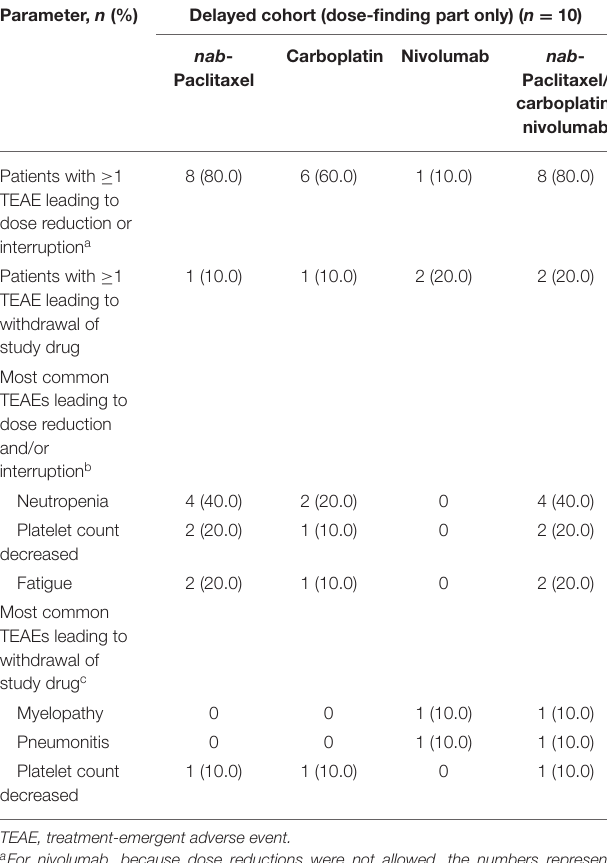
Table 3a | TEAEs leading to dose reduction, interruption, or discontinuation in the concurrent nivolumab cohort. Parameter, n (%)